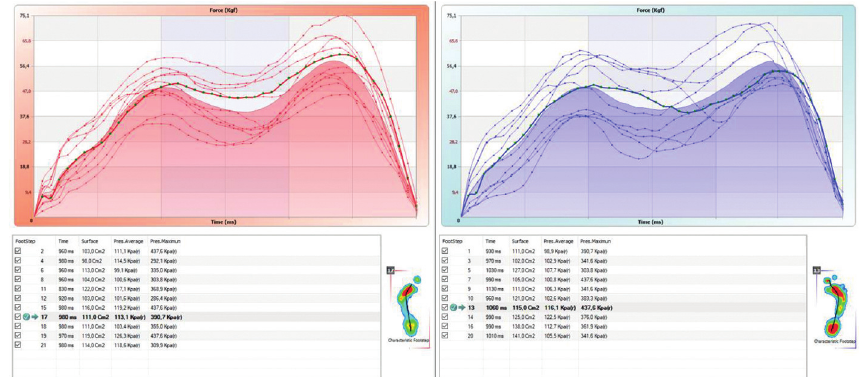
Figure 11: The results of the examination of the distribution of forces and time-space parameters while walking, patient no. 7.